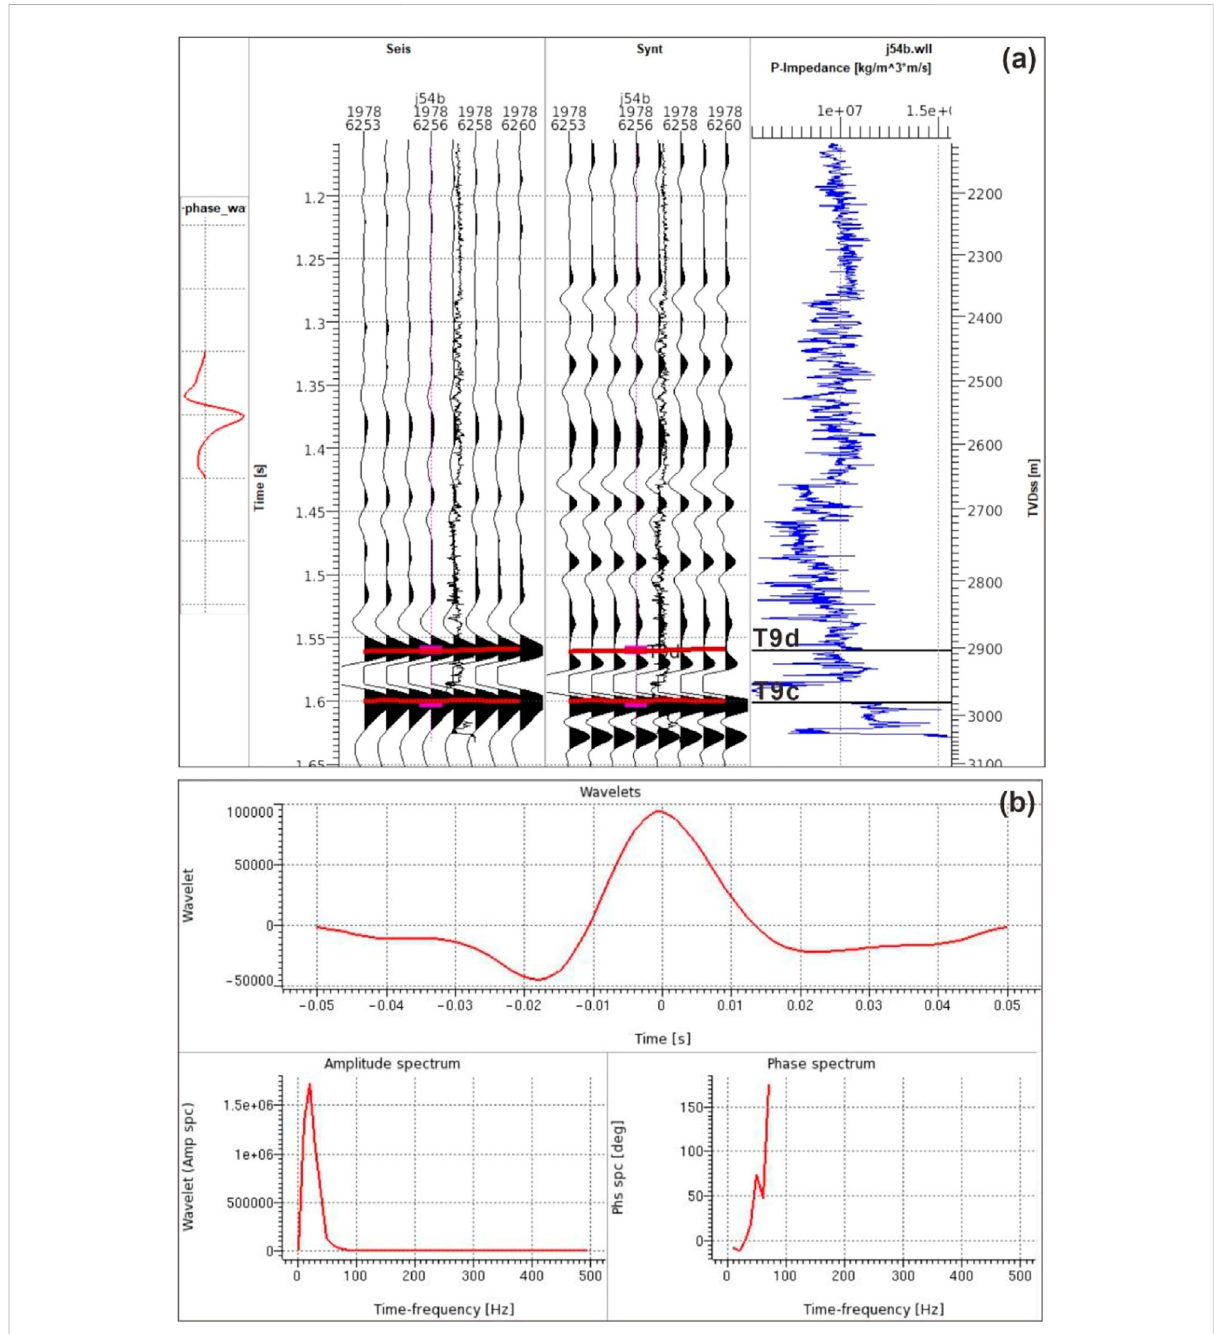
(Figure 5A). The sensitivity of the inversion procedure was evaluated with the aid of the various wavelets that were retrieved. Within the context of the seismic survey, the well placements and overall quality served as the